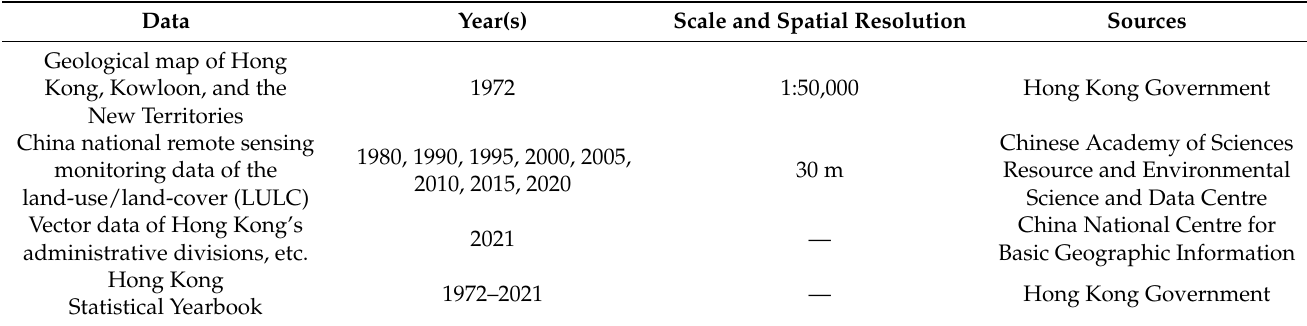
Table 1. List of data